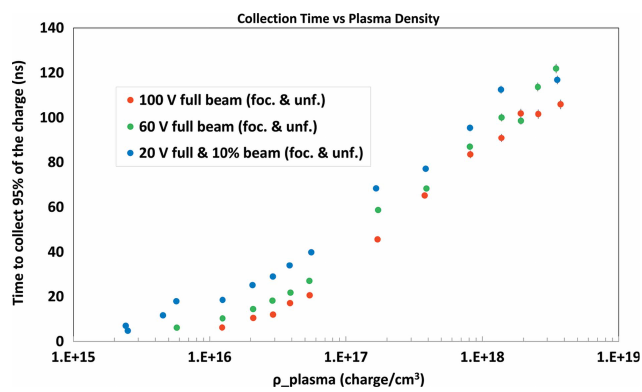
Figure 11 Time required to collect 95% Q coll ( t ! 1 ) as a function of plasma density, for various detector-biasing